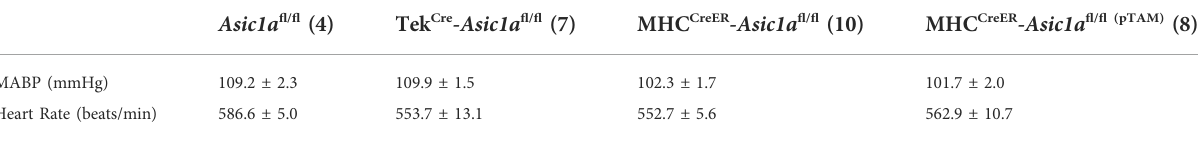
TABLE 3 Mean arterial blood pressure (MABP) and heart rate in genetically-modi fi ed mice treated with or without tamoxifen